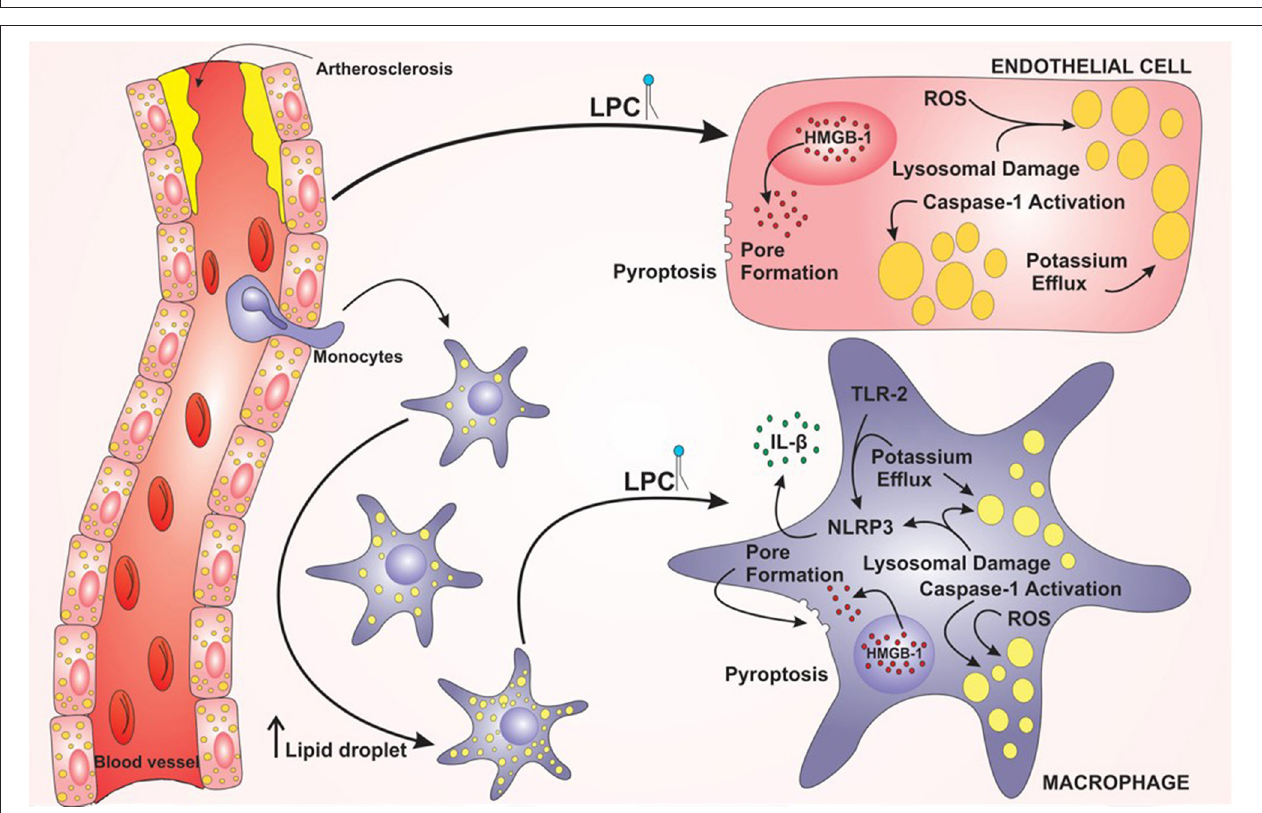
FIGURE 6 | stimulated with different concentrations of LPC. Twenty-four hours later, the cells were incubated with MTT to evaluate the cytotoxicity. (E) Human endothelial cells and (F) human monocytes were stimulated with 1, 10, and 20 µ g/ml of LPC. After 24h, the LDH release was quantified. The bar graphs represent one experiment performed three times in triplicate. Each bar shows a significant difference and represents a confidence interval of 95% (* p < 0.05, ** p < 0.01, *** p < 0.005, and **** p < 0.0001) with the unstimulated control. (G) Human endothelial cells and (H) human monocytes were stimulated with 10 µ g/ml of LPC. After 18h, the cells were stained with anti-HMGB1 conjugated with Alexa 546 and labeled with DAPI to visualize the nuclei. Images were taken by confocal microscopy. UNS: unstimulated cells. Bright field images were used as a morphology control. Scale bar, 25 and 10 µ m. Human endothelial cells were stimulated with 1 and 10 µ g/ml of LPC. After 24h, the protein levels of (I) HMGB1 and (J) cleavage of GSDMD were examined by western blot analyses. Beta actin was used as an internal control.